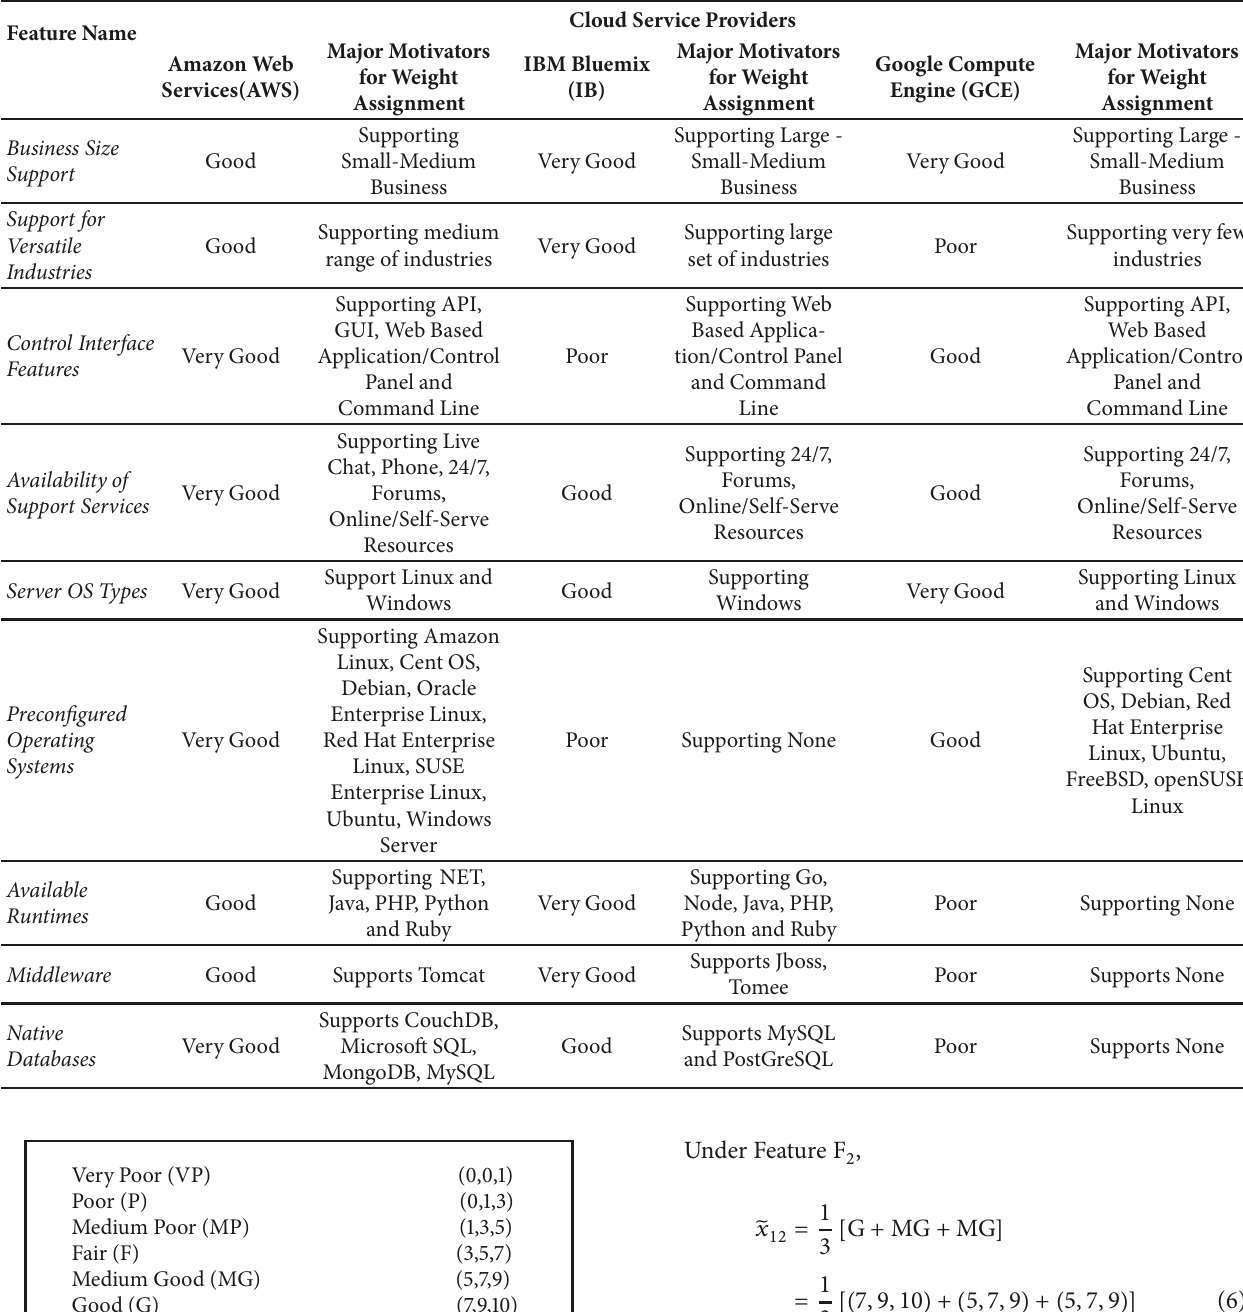
Table 2: Cloud service providers and feature